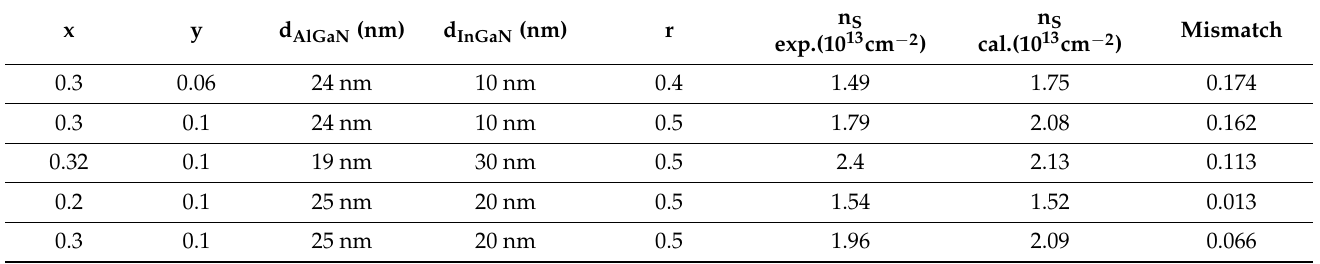
Figure 7. Comparison of model calculation results by (8), and experimental data. Table 2. The 2DEG density between the model calculation (cf Equation (8)) and the experimentally reported data. Refs. [18,19] is shown.